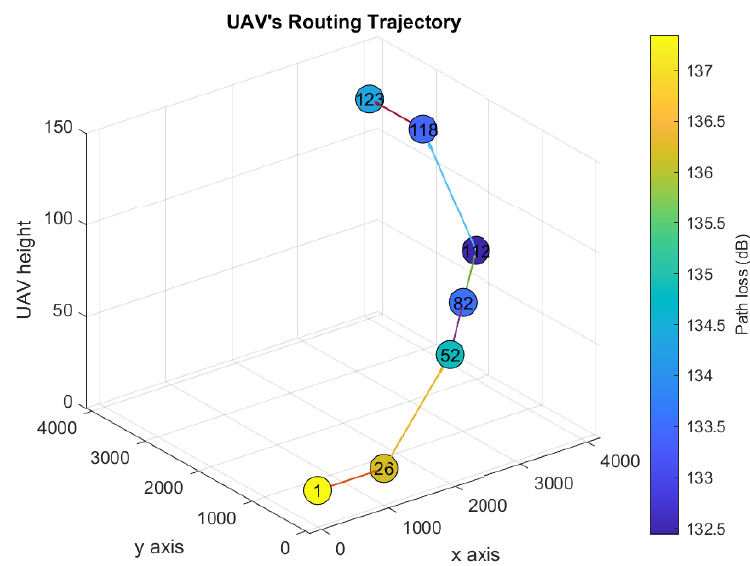
Figure 8. Optimal UAV’s trajectory design over the path loss map (Scenario 2). Table 3. Computational